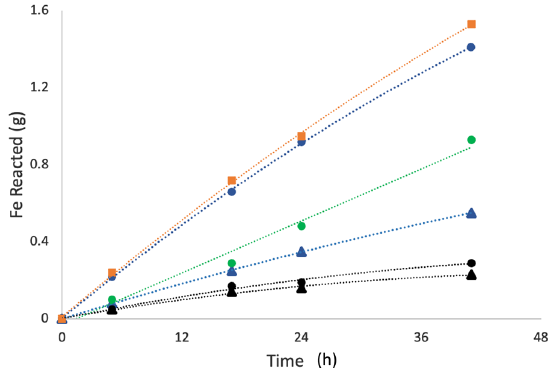
Fig. 3 Reaction progress curves. Aged Rhodes steel wool (2.0 g) reactions with 170 mL DW vinegar (squares), 5 vol% acetic acid (circles), nitrogen-sparged 5 vol% acetic acid (triangles). Reactions with no added phosphate (orange and black; top line and bottom two lines), 0.10 mM phosphate added (green; 3rd line from top), and 1.0 mM phosphate added (blue; 2nd line from top and 4th line